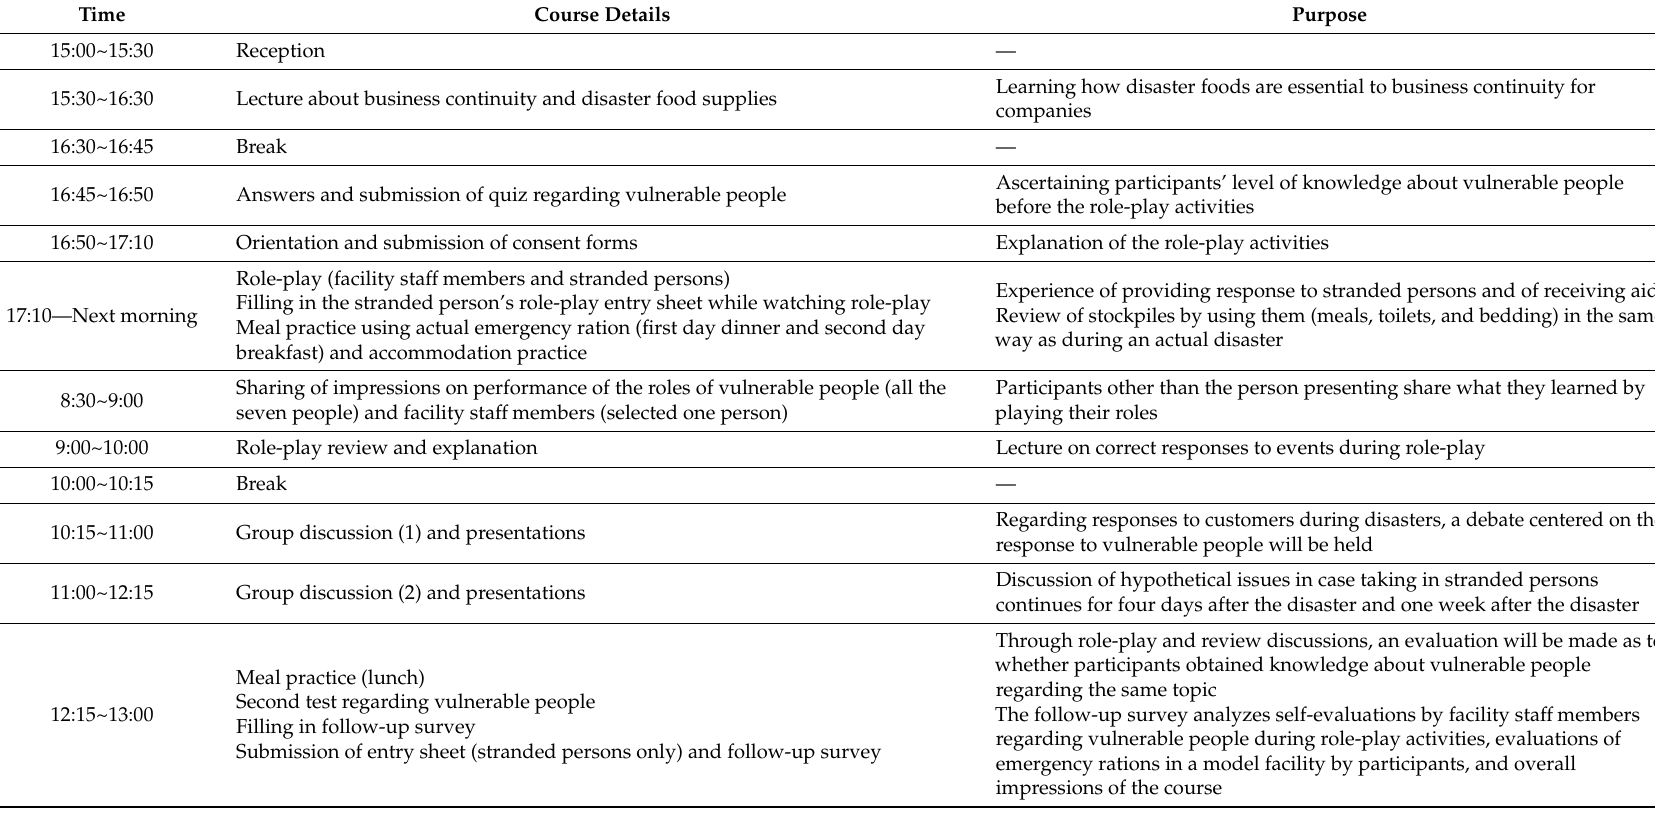
Table 1. Organization of the